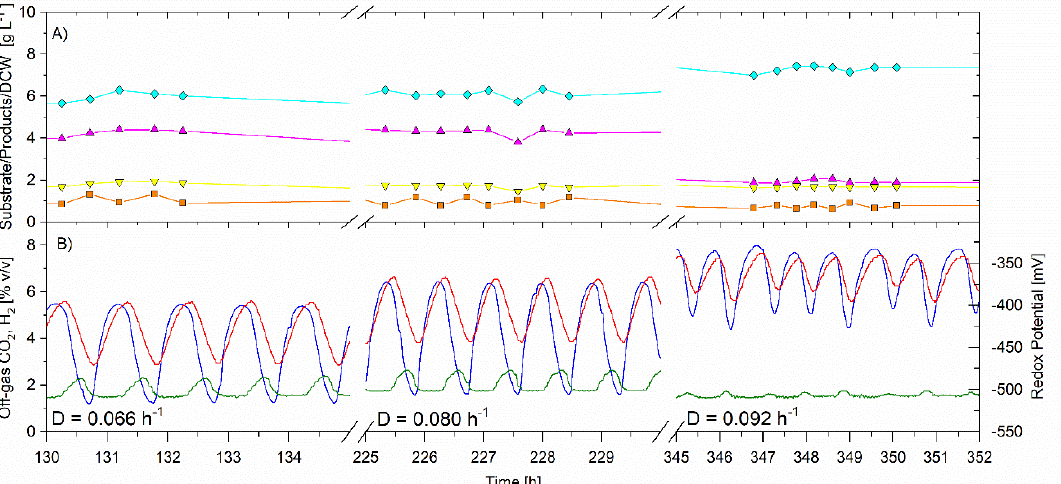
Figure 5. Continuous fermentation showing the effect of dilution rate on the self-synchronized oscillatory metabolism, dilution rate, Temperature 35.5 °C , D = 0.066 h − 1 (10 to 156 h); D= 0.080 h − 1 (156 to 252 h); D= 0.092 h − 1 (252 to 372 h), feed glycerol 31.1 ± 0.5 g·L − 1 . On-line analysis of off-gas (sample frequency 1 min) of: CO 2 (red) and H 2 (blue), % v / v ; redox potential, mV (green). Off-line analysis via HPLC of bioreactor in g·L − 1 of: glycerol (solid orange square); PDO (solid magenta triangle); butanol (solid cyan diamond); ethanol (solid inverted yellow triangle).